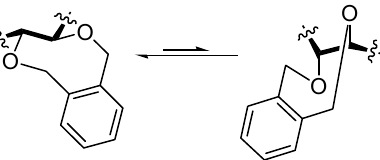
Figure 9 . Schematic representation of o -xylylene-protected trans -diequatorial (left) and trans-diaxial (right) 1,2-diol segments.